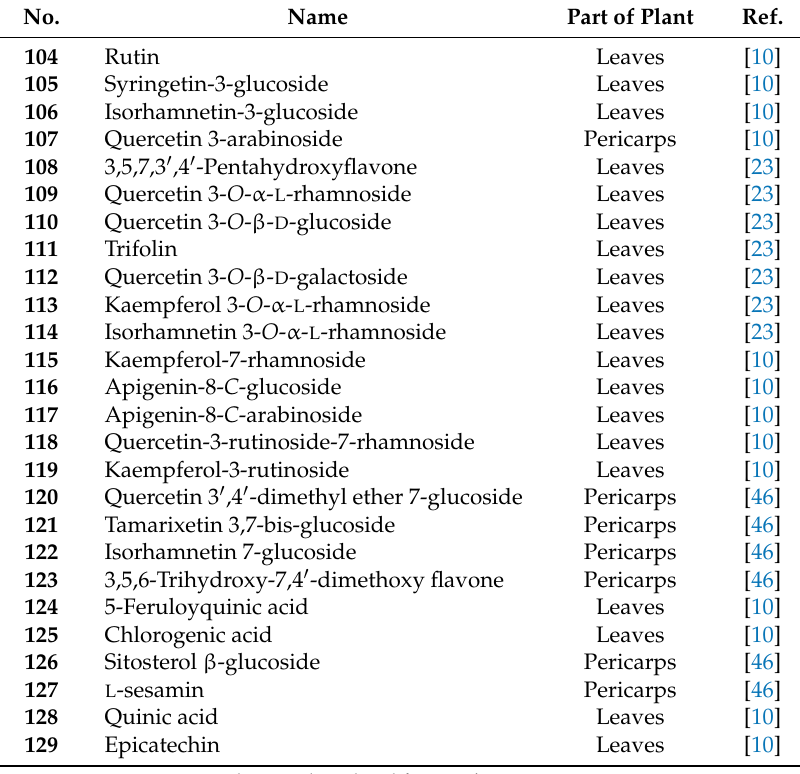
Table 4. Flavonoids isolated from Z. bungeanum ( 104 – 129 ).